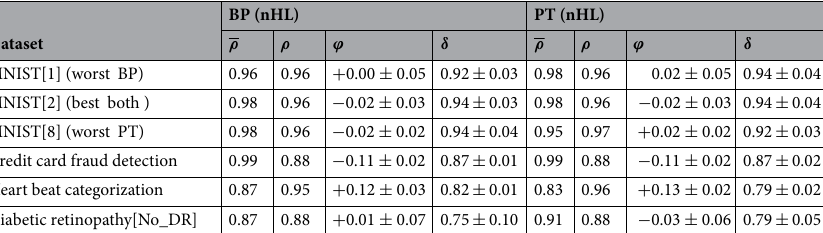
Table 4. Comparison, with focus on δ (and on ϕ ), between BP and PT applied to medium-size datasets (all from the Kaggle ML repository). The comparison has been performed using the train-and-test strategy. Non binary datasets have been preventively binarized (for the sake of brevity, only the best and the worst cases have been reported for the dataset MNIST). Experimental runs have been repeated 4 times. Also standard deviation is reported for both ϕ and δ .